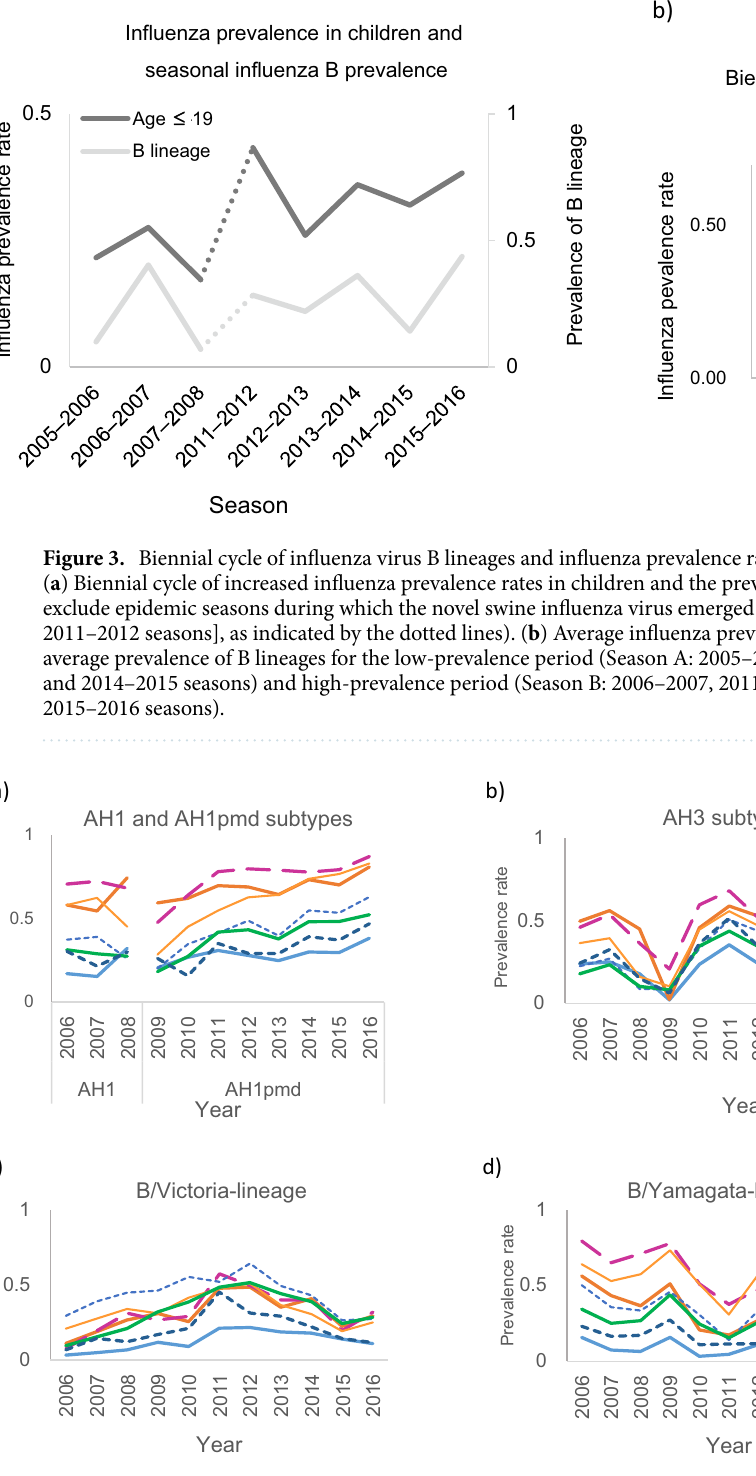
Figure 4. Yearly prevalence rate of hemagglutination inhibition (HAI) titers (≥ 1:40) for the influenza virus by age group. Prevalence rate of serum antibodies against influenza virus strains by age group presented for titers ≥ 1:40, as measured in approximately 6000 people in Japan each year using the HAI assay. In ( a ), the prevalence rate of serum antibodies against A(H1N1) is presented for years between 2006 and 2008, and the prevalence rate of serum antibodies against A(H1N1)pdm09 is presented for years between 2009 and 2016, although the subtypes of A(H1N1) and A(H1N1)pdm09 were genetically